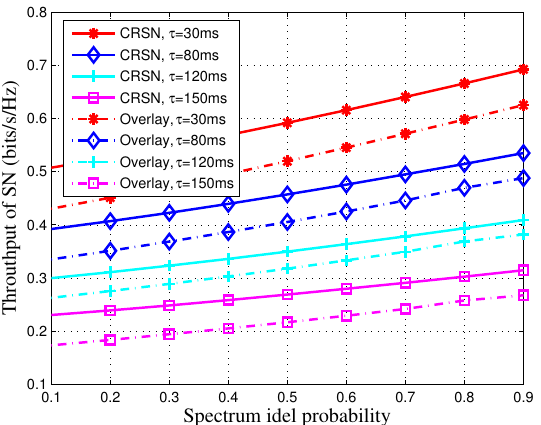
Figure 2. SN’s average throughput of the proposed strategy as a function of the spectrum idle probability. The transmit power of the primary transmit (PT) is set to P b = 15 dB, and the target secrecy outage probability is set to P th = 0.1.